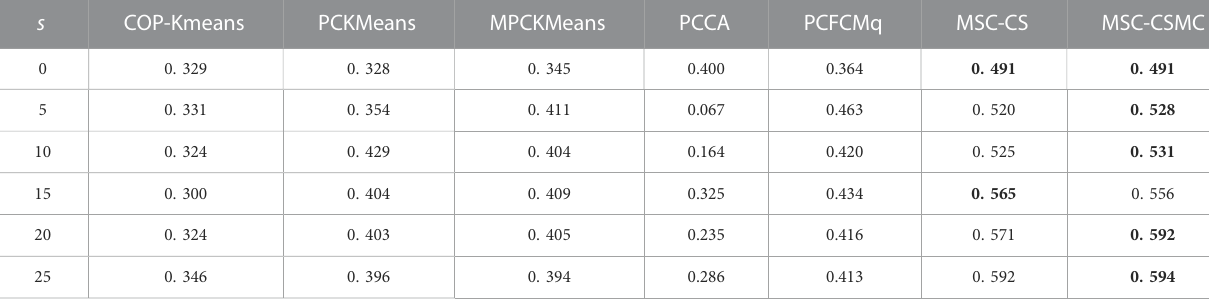
The bold values indicate the optimal solutions in each row.